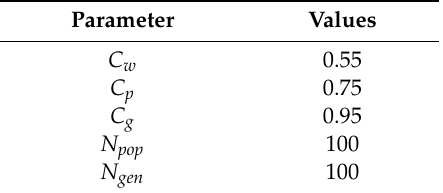
Table 3. Parameters of simplified swarm optimization (SSO).